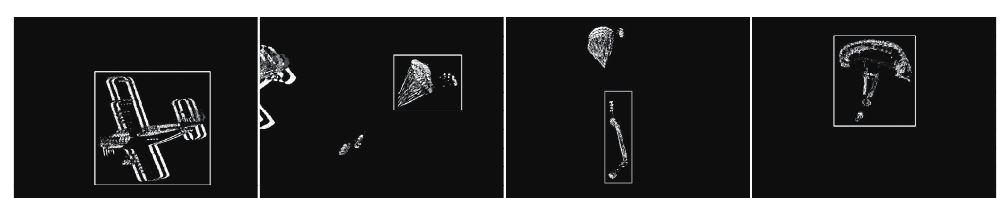
Figure 9. Target